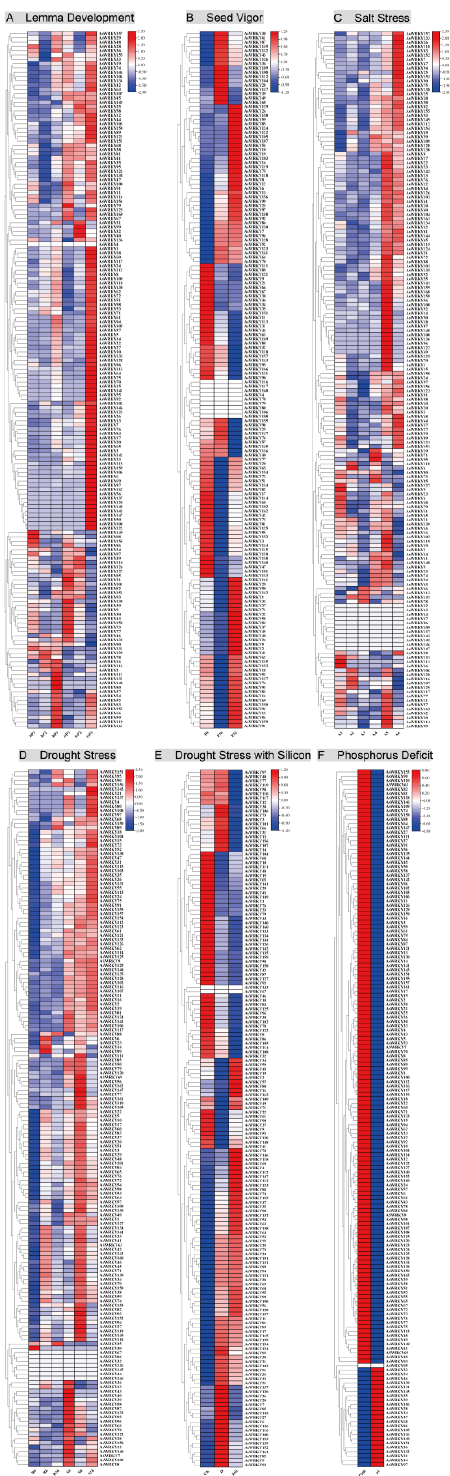
Figure 9. Expression pattern of 162 AsWRKY genes in different development stage or adversity based on RNA-seq data. ( A ) The comparison of lemma development between BY685 and OA1613 varieties at the P1, P2, and P3 stage. ( B ) The comparison of seed vigour after seeds aged 0 days (P0), 16 days